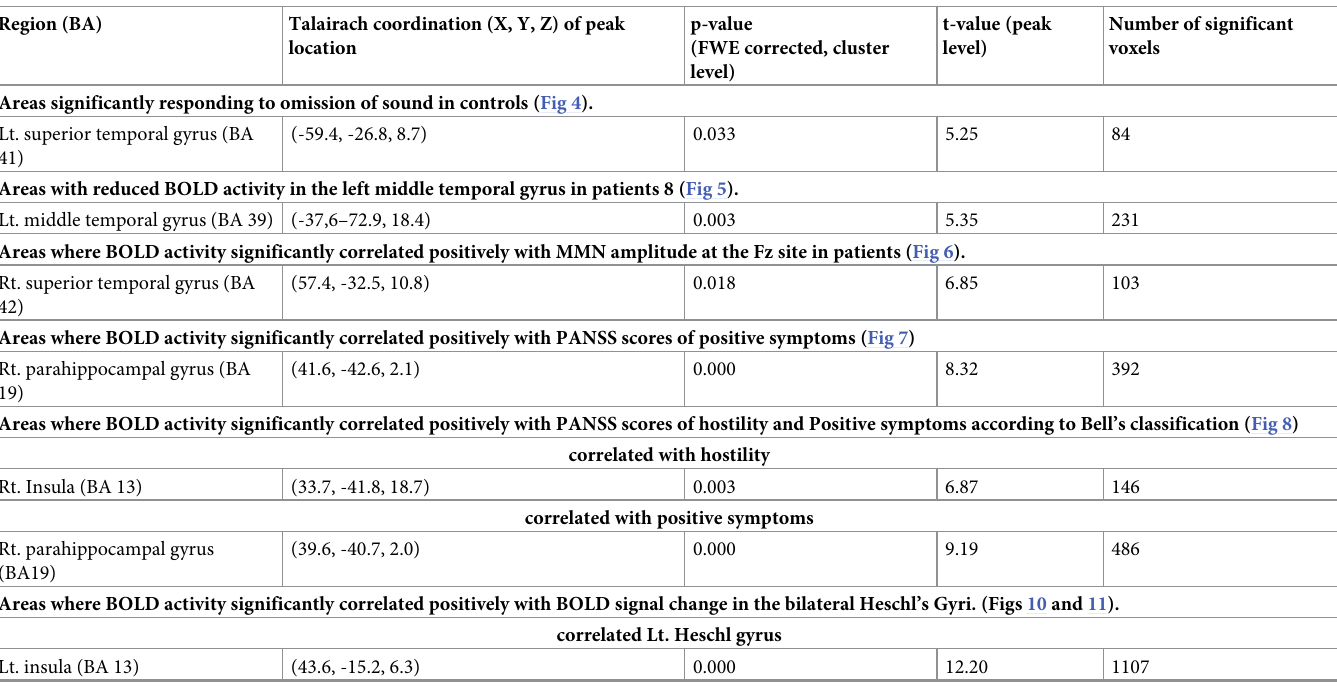
Table 2. Areas significantly responded to sound omission or correlated to other measures. Region (BA) Talairach coordination (X, Y, Z) of peak